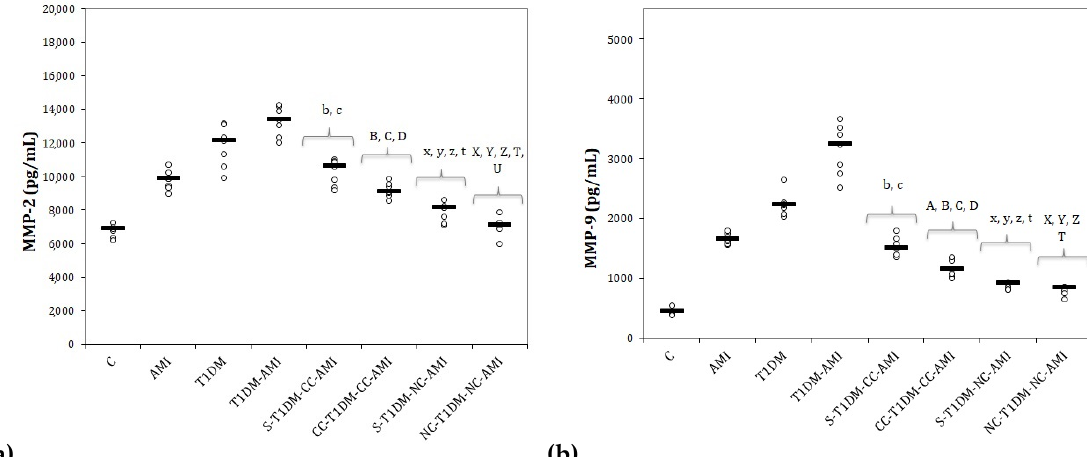
Figure 9. Serum levels of matrix metalloproteinases: ( a ) Matrix metalloproteinase 2 (MMP-2); ( b ) matrix metalloproteinase 9 (MMP-9). C—control; AMI—acute myocardial infarction; T1DM—type 1 diabetes mellitus; S—saline (0.09%); CC—conventional curcumin solution (200 mg/Kg bw); NC—solution of curcumin nanoparticles (200 mg/Kg bw). The letters correspond to p values <0.05: (b) S-T1DM-CC-AMI compared to T1DM; (c) S-T1DM-CC-AMI compared to